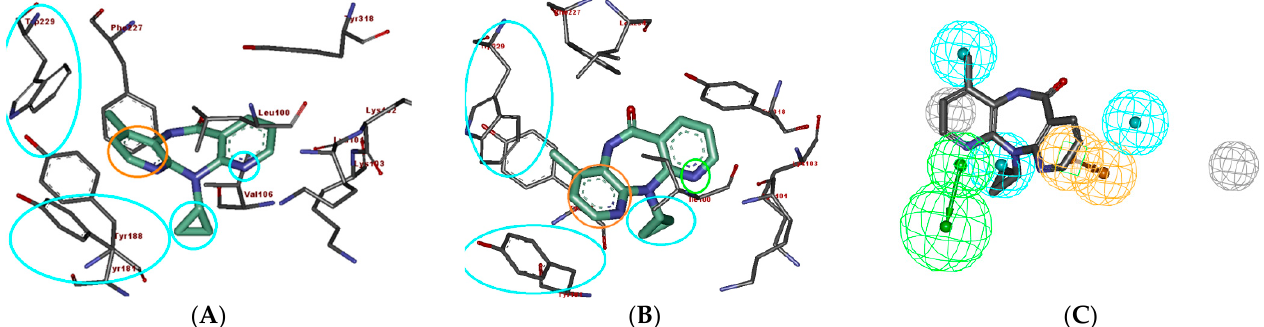
Figure 5. ( A ) PDB ID:1IKW, the co-crystal structure of Nevirapine and theNNRTase active site with important binding interactions [48]. ( B ) The co-crystal structure of Nevirapine and theNNRTase active site with important binding interactions, PDB ID: 1S1U [25]. ( C ) Comparison of the pharmacophore mapping of Nevirapine on Hypo-1.